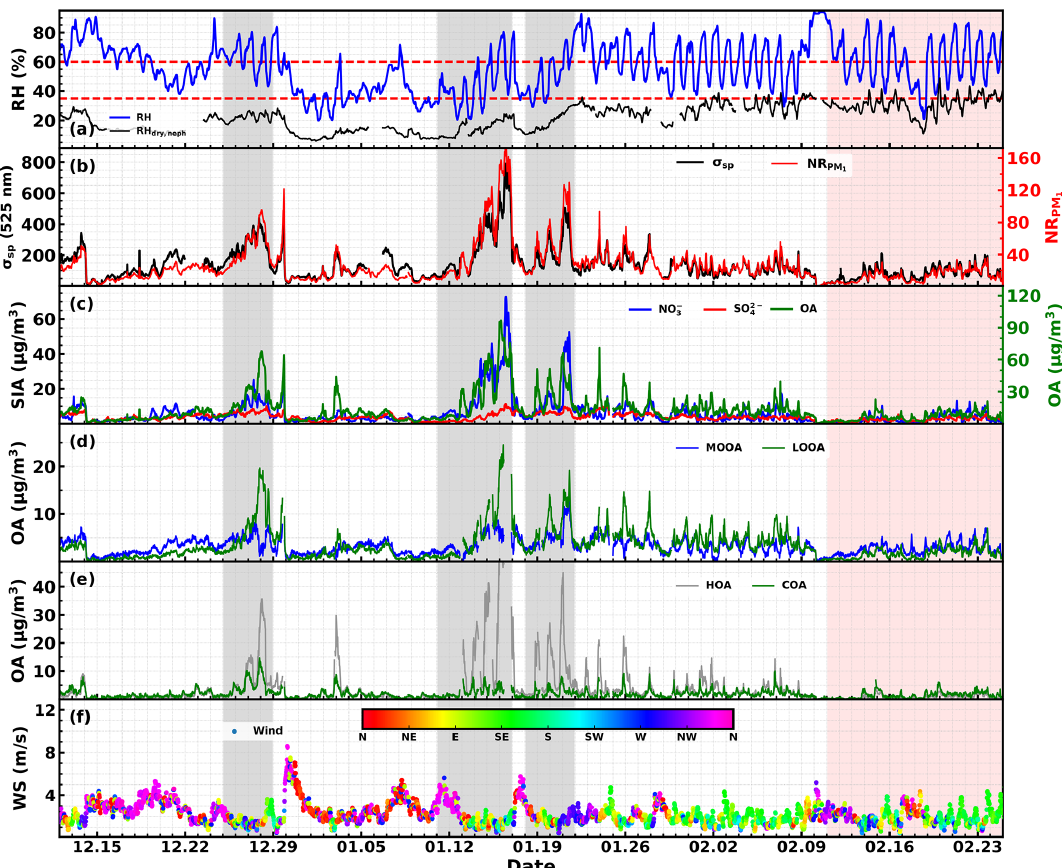
concentration; (c) secondary inorganic aerosols 1